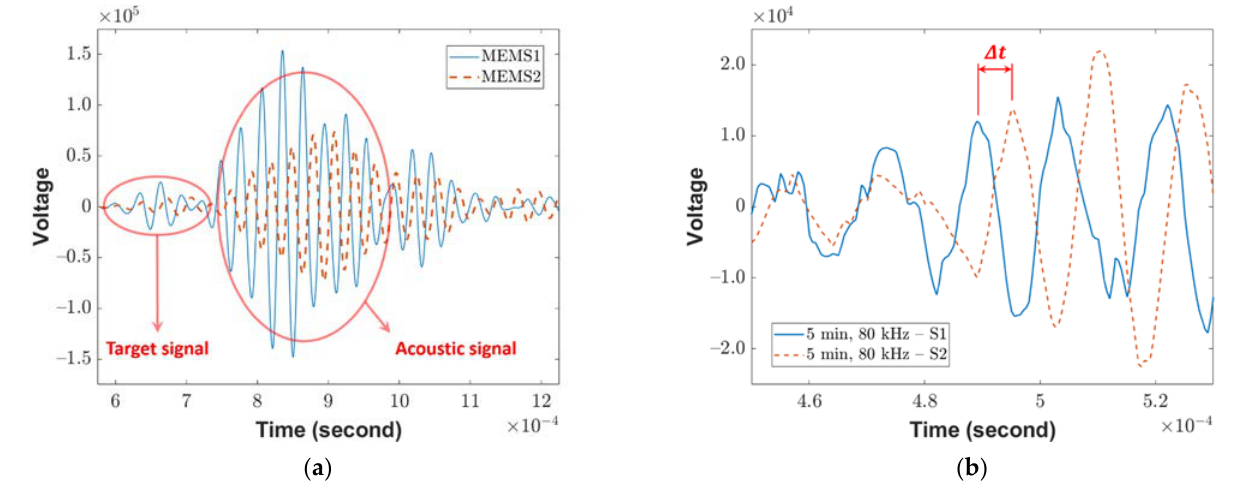
Figure 4. Raw data obtained from ( a ) surface wave experiment with 80 kHz impulse, five minutes after mixing concrete and ( b ) the raw data of P-wave S1 and S2. The ∆ t is calculated from the first peak of each sensor.